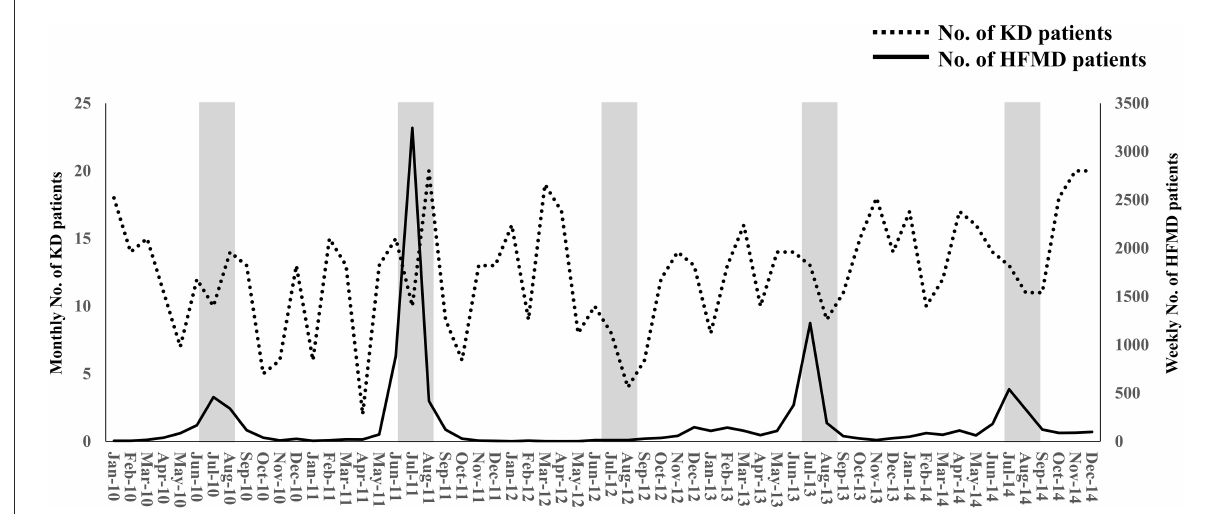
FIGURE1 The monthly number of KD patients and the weekly number of HFMD patients during the study period. The weekly number of HFMD patients was reported from 24 sentinel medical facilities in Kitakyushu City. The left and right Y-axes indicate the monthly number of KD patients and the weekly number of HFMD patients, respectively. The gray zones indicate July and August. KD, Kawasaki disease; HFMD, hand-foot-mouth